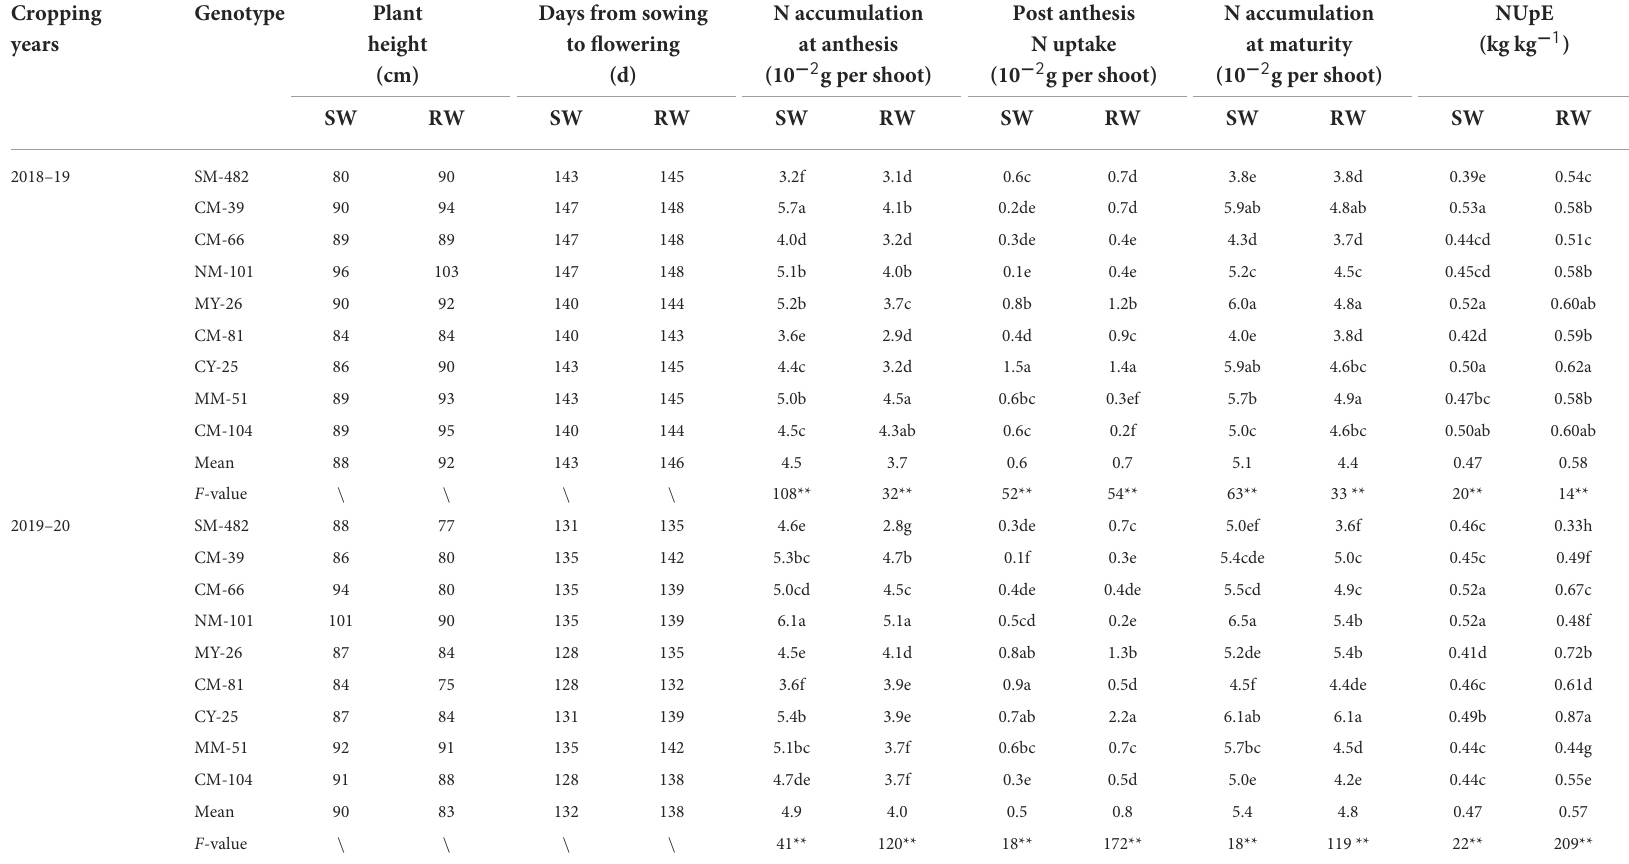
TABLE 5 The N uptake-related traits of nine wheat genotypes in two wheat cropping systems and two cropping years.